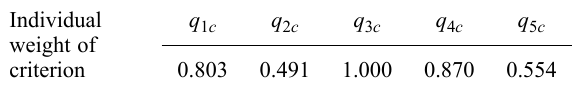
Table 6. Individual weight of